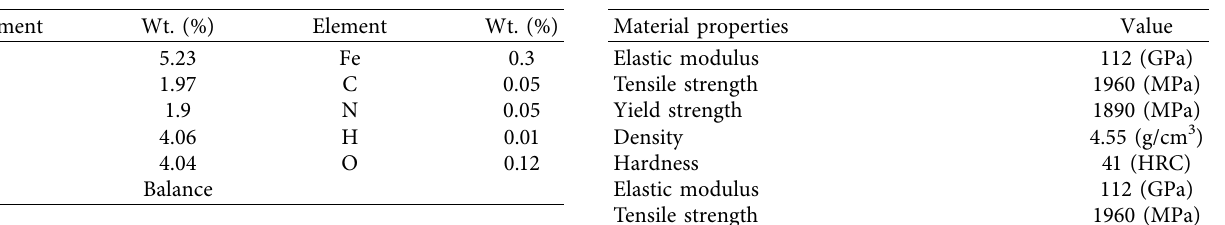
Table 1: Chemical composition of TC17. Table 2: Material properties of TC17.